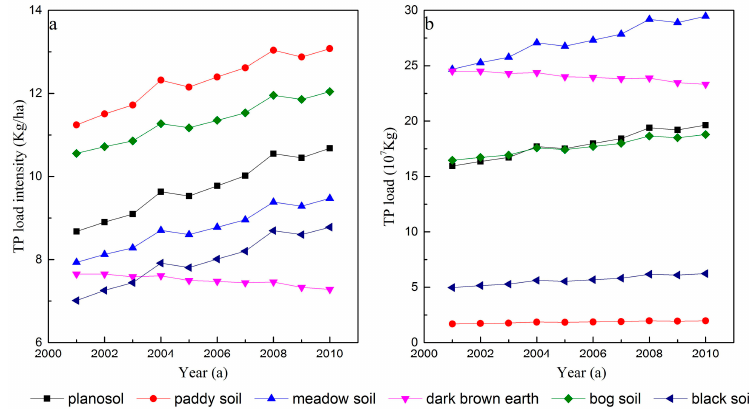
Figure 10. Load ( a ); and load intensity ( b ) of total phosphorus (TP) from each soil type between 2001 and 2010.